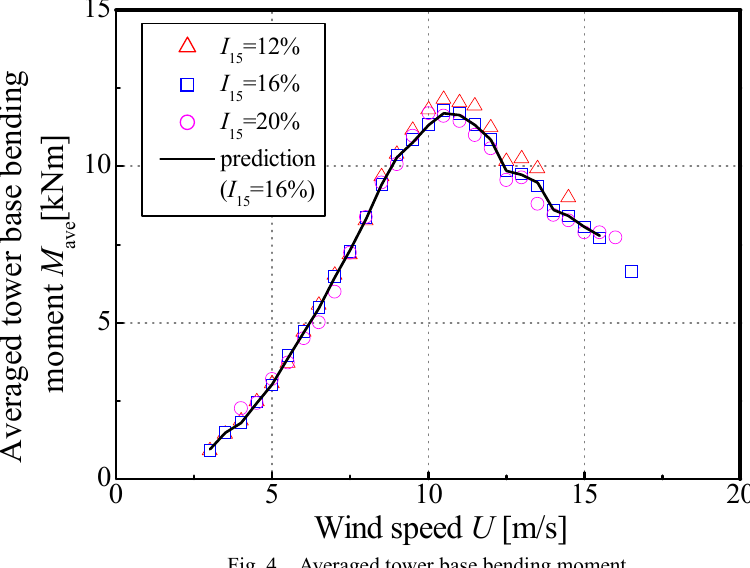
Fig. 4 Averaged tower base bending moment.